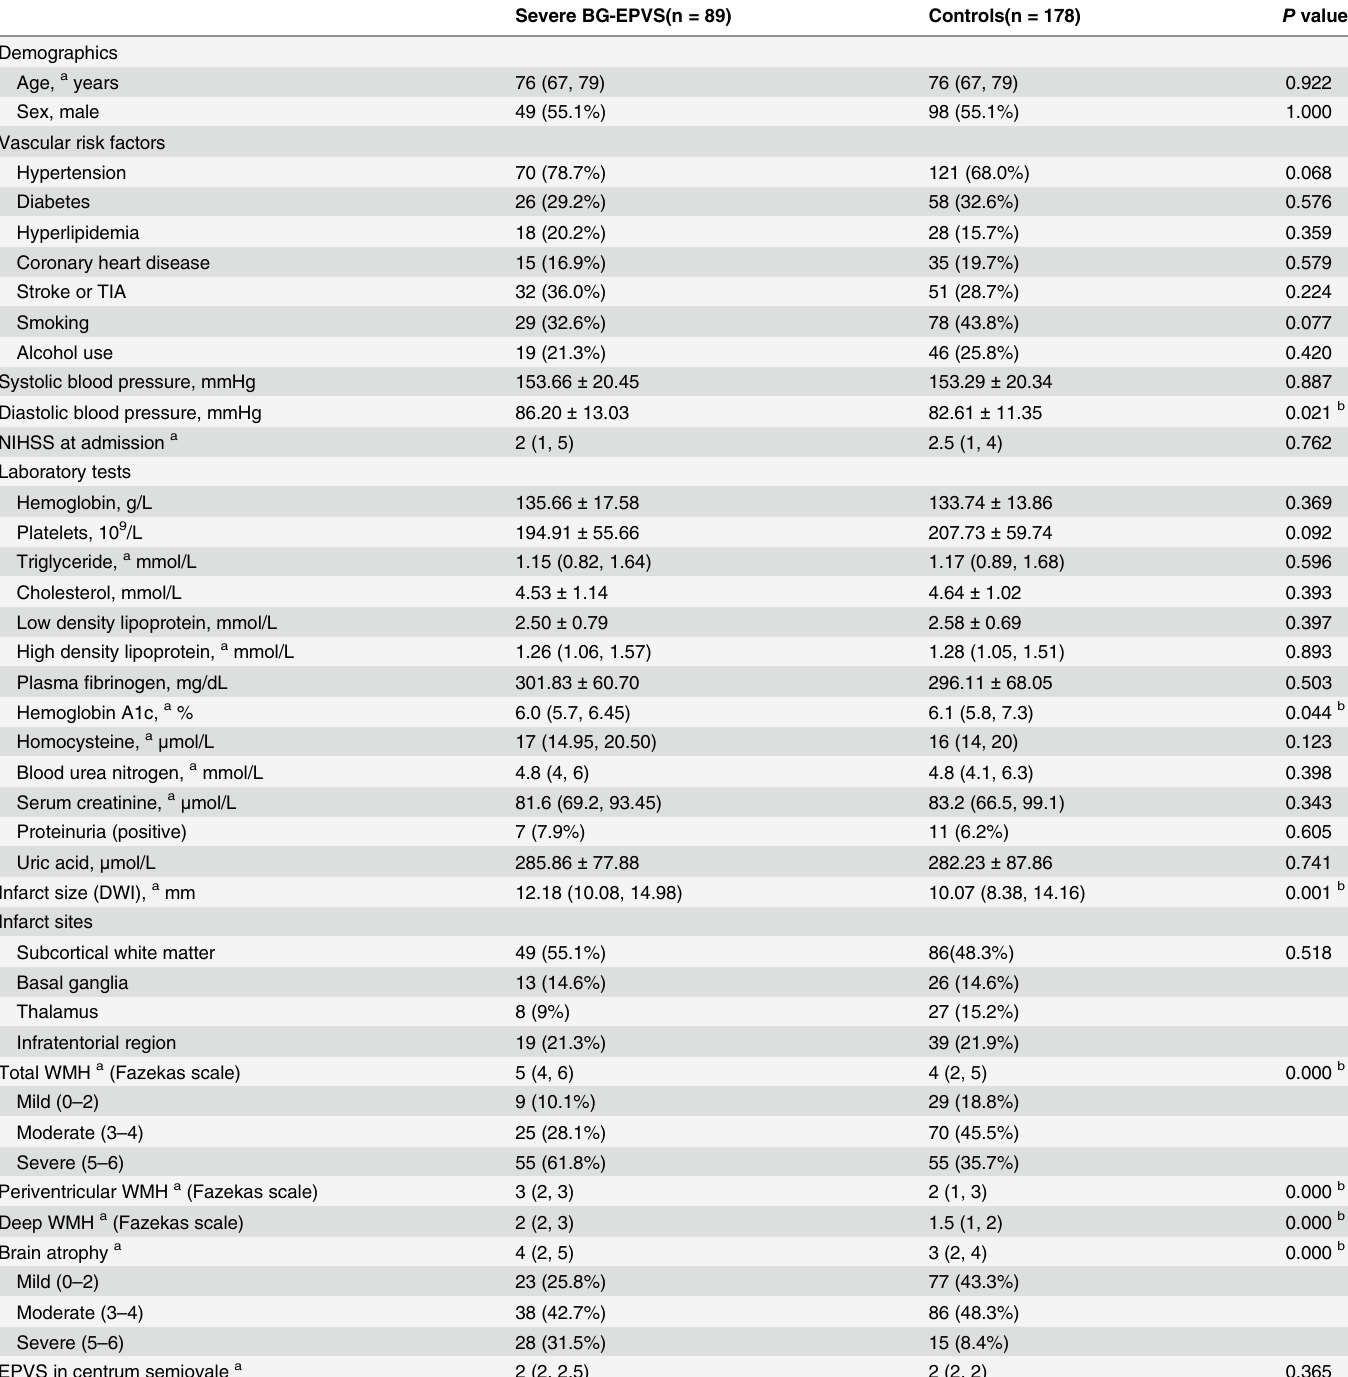
Table 1. Characteristics between patients with and without severe